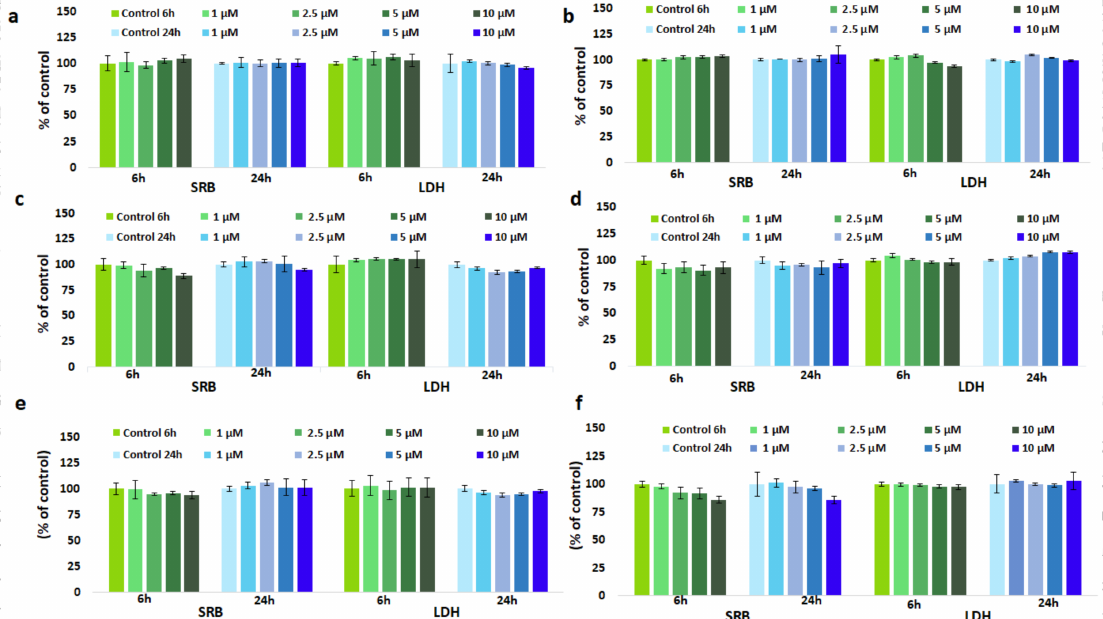
Figure 2. Viability and cytotoxicity evaluation in SVEC4-10 cells in the presence of increased concentrations of ( a ) GdDOTP citric acid, 2.5 mg · mL − 1 CS; ( b ) GdDOTP acetic acid, 2.5 mg · mL − 1 CS; ( c ) GdDOTP citric acid, 1.5 mg · mL − 1 CS; ( d ) GdDOTP acetic acid, 1.5 mg · mL − 1 CS; ( e ) GdDOTA citric acid, 1.5 mg · mL − 1 CS; ( f ) GdDOTA acetic acid, 1.5 mg · mL − 1 CS, after 6 and 24 h. Unloaded